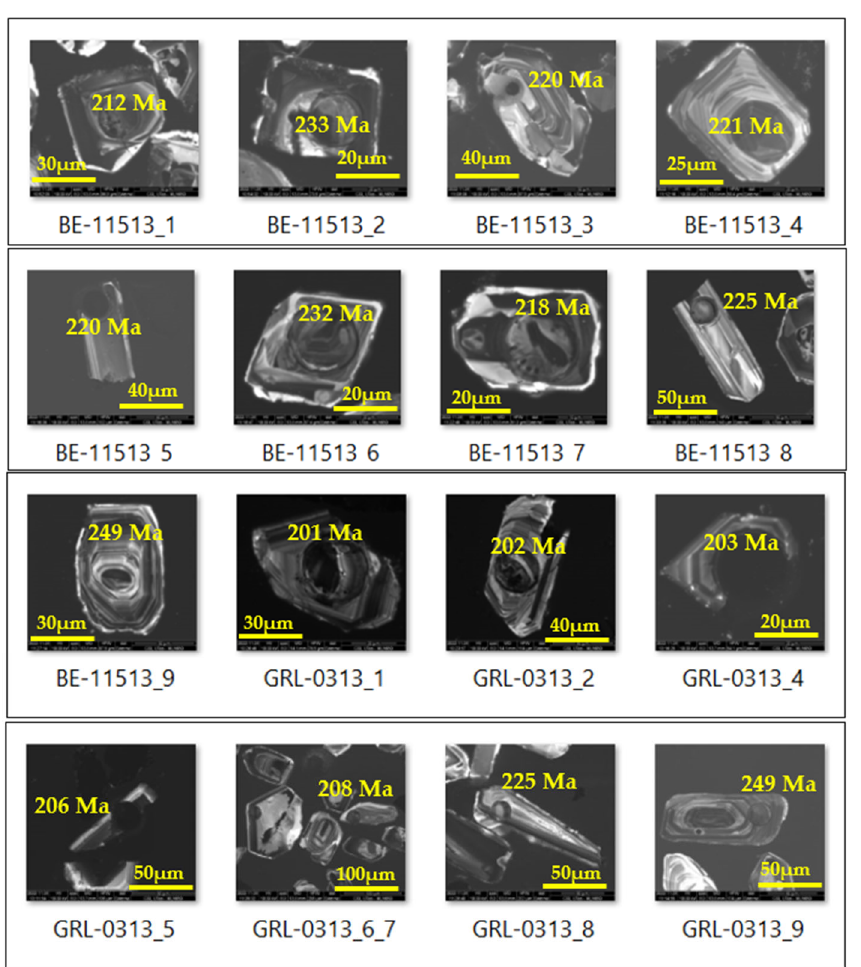
Figure 9. Cathodoluminescence (CL) images of zircon grains from the Bentong area and Langkawi Islands, Malaysia. The round feature represents the position of the laser craters.